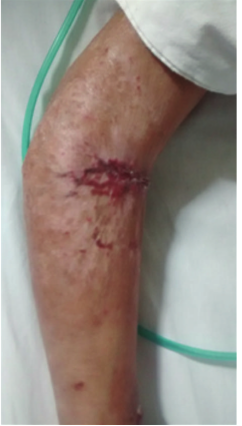
Figure 4: Scar lesion. Appearance of lesion recovery after 45 days of corticosteroid